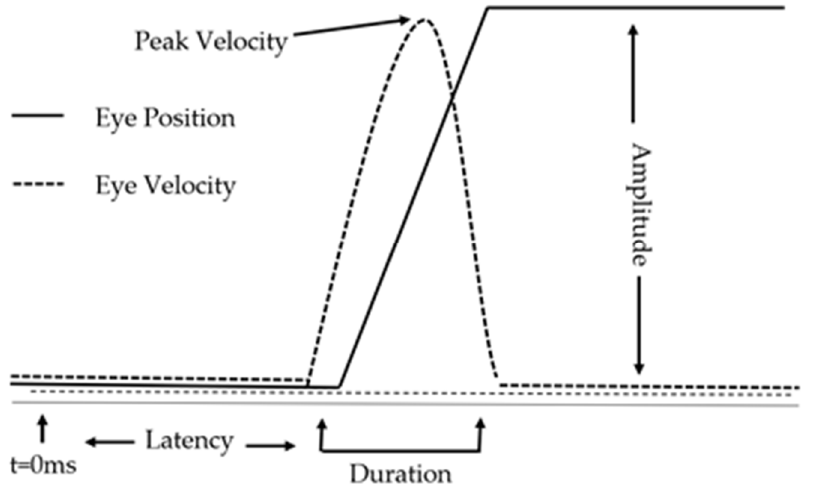
G . The profile of each individual saccade. Figure 1. Example visual displays and eye movements patterns of a prosaccade task (Panel ( A )), antisaccade task (Panel ( B )), reading task (Panel ( C )), static image search task (Panel ( D )), visual paired comparison task (Panel ( E )), face processing task (Panel ( F )), and individual eye movement pattern (Panel ( G )). Note, as studies that incorporated every-day tasks and real-life simulations did not present a fixed visual display, this task has been omitted from this figure. Panel ( F ): In each case (( A – E ) above), the pattern of eye movement will consist of an individual component of saccadic eye movements with a characteristic profile, consisting of saccadic amplitude, duration, and peak velocity.